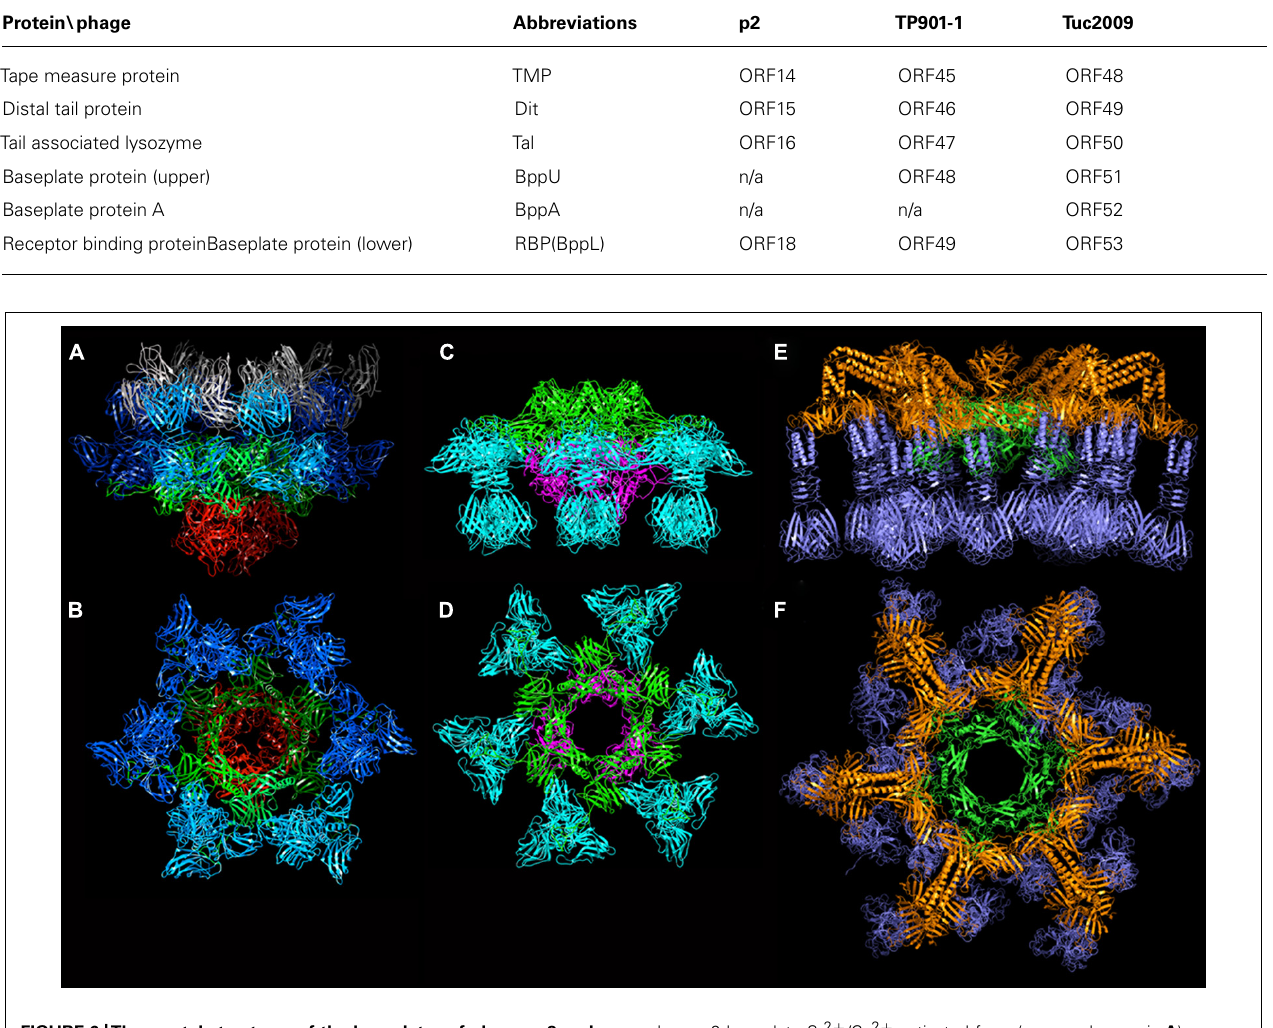
phage p2 baseplate Sr 2 + /Ca 2 + activated form (same colors as in A ). (D) Top-view of the phage p2 baseplate Sr 2 + /Ca 2 + activated form. (E) Side-view of the phage TP901-1 baseplate (ORF46/Dit, green; ORF48/BppU, orange; ORF49/RBP, violet). (F) Side-view of the phage TP901-1 baseplate (same colors as in E